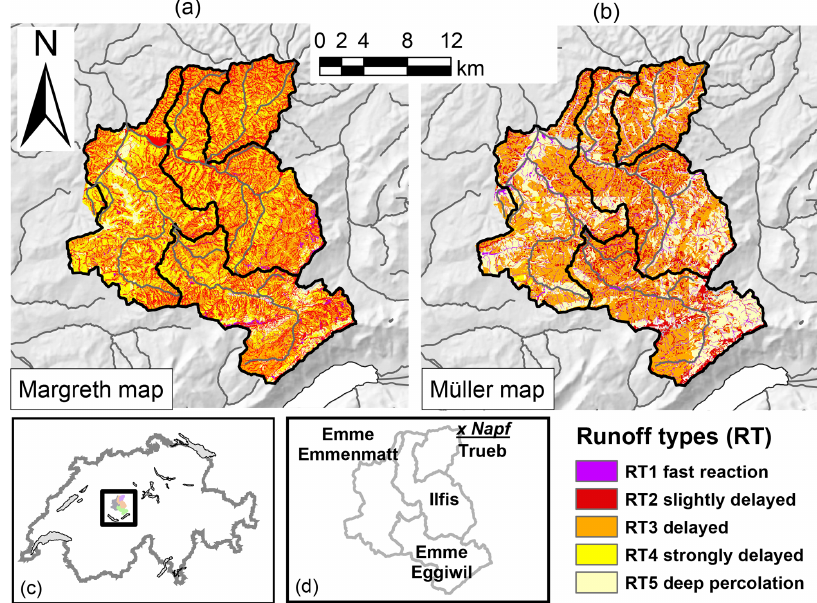
Figure 1. Overview on the investigated Emme catchment. (a) a process map according to Margreth et al. (2010); (b) a process map according to Müller et al. (2009); (c) the location of the target area within Switzerland and (d) the situation of the nested sub-areas and location of the Napf meteorological station. GIS elements are reproduced by kind authorisation of swisstopo (JA022265), BFS